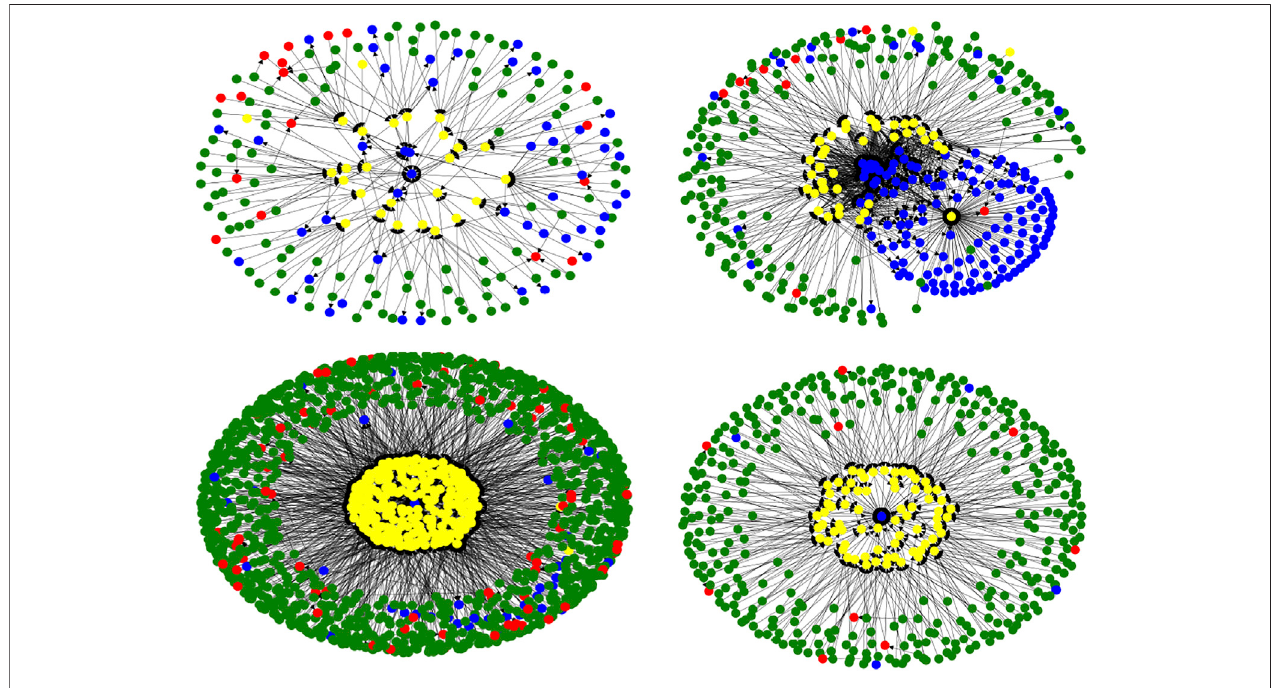
FIGURE 10 | network connections around four key name servers.